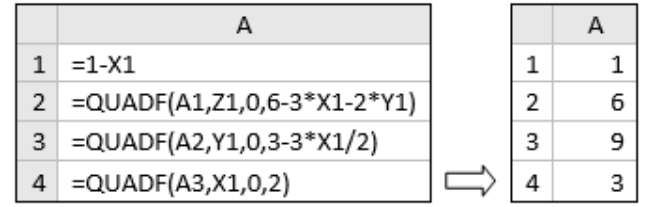
Figure A4 . Demonstration of QUADF for computing multiple integral (A4) in Excel.